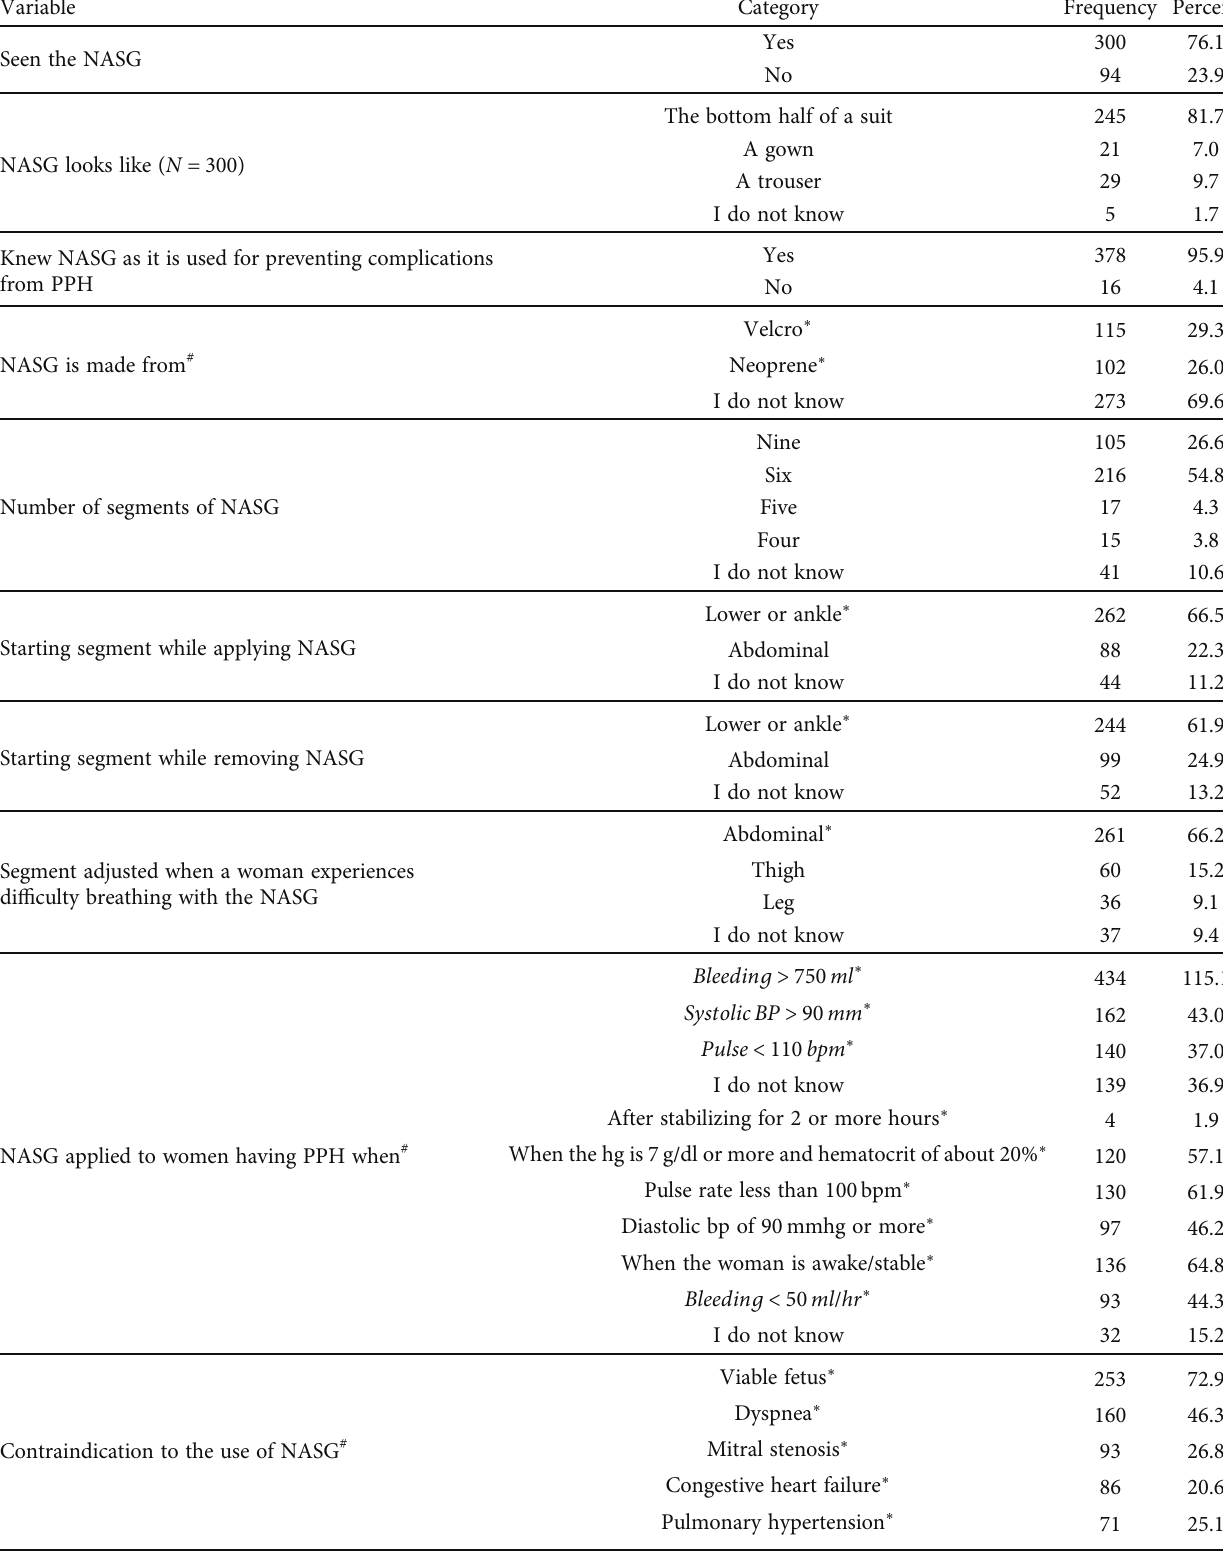
Table 3: Knowledge of respondents who participated in the study and were working in public hospitals of Sidama region, Ethiopia, 2022 ( N = 394